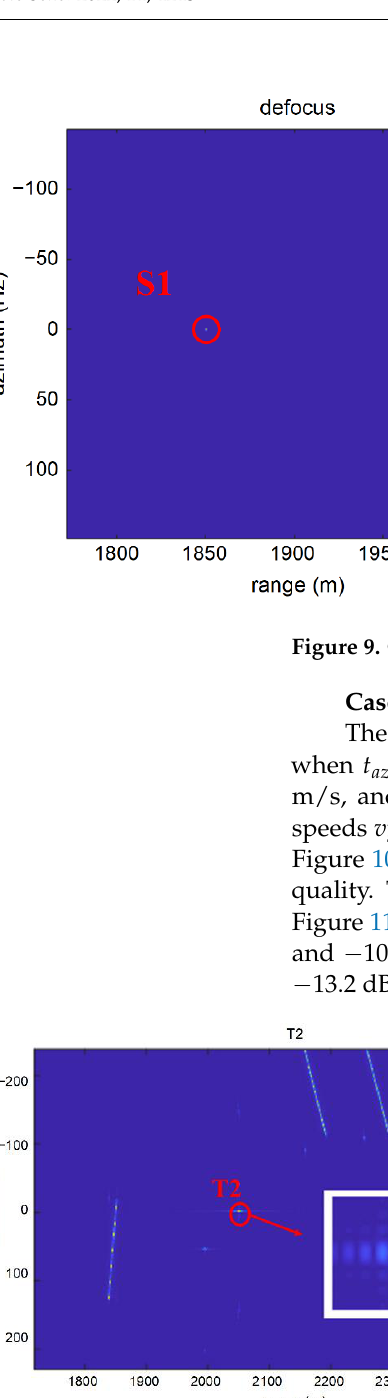
Figure 10. Refocused result of the moving target T2 and T4.